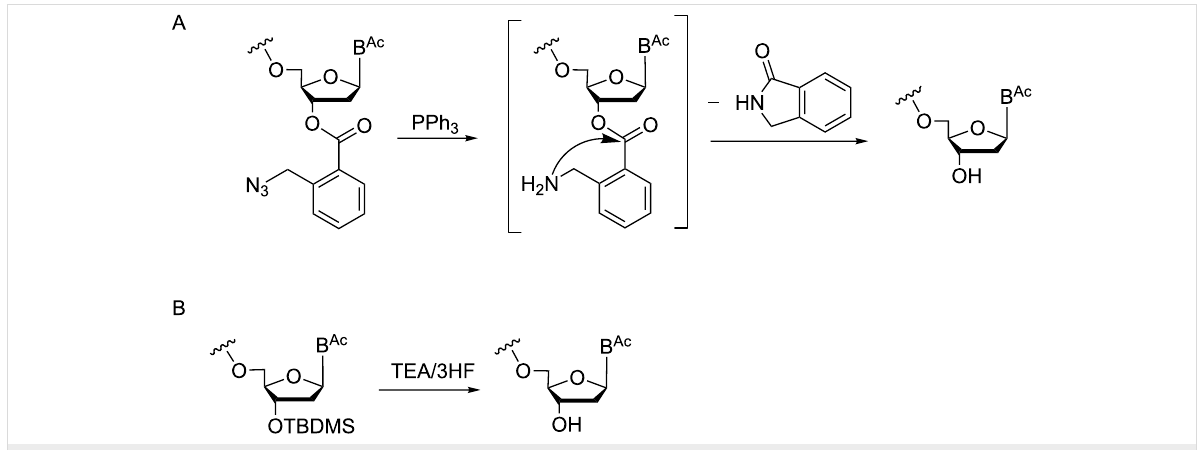
Figure 4: Removal of the 3'-O-protecting group under conditions that leave all other protecting groups at 5'-OH, nucleobases and internucleotide phosphates intact.